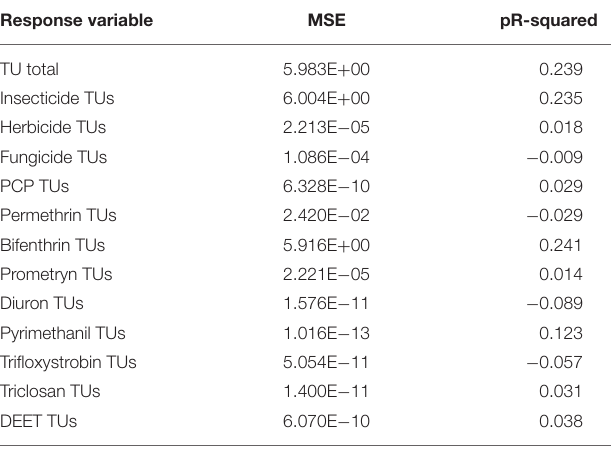
TABLE 2 | Model performance summary by class and compound.